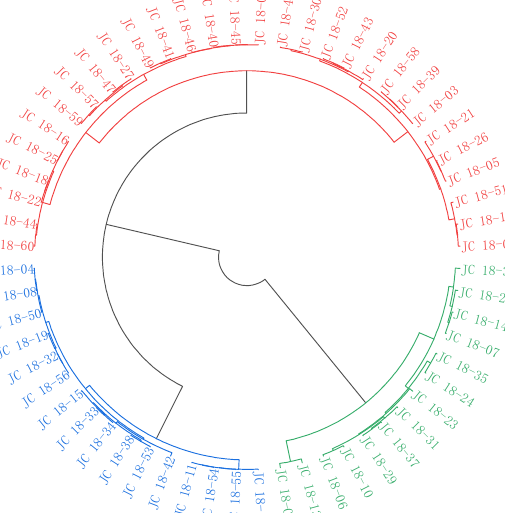
Figure 6. Cluster analysis of mustard resources based on glucosinolate contents. Used the same method as above, 60 mustard resources were divided into three groups at the Euclidean distance of 90.0. (Blue: group I; red: Group II; green: group III).